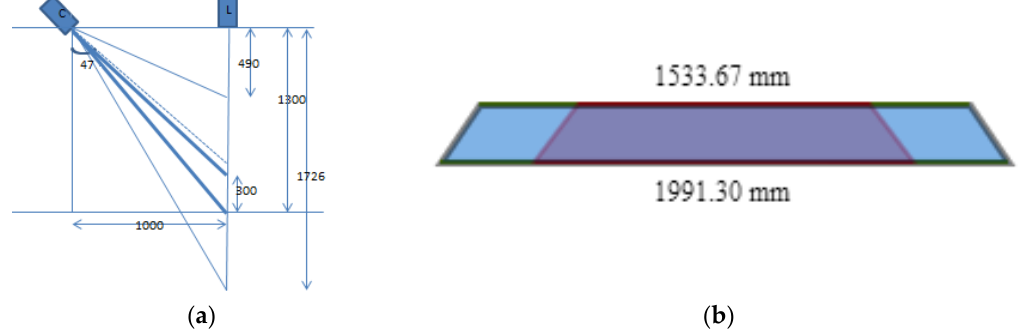
Figure 8. ( a ) The Sketch Map of the Optical Layout; ( b ) The Camera Field.